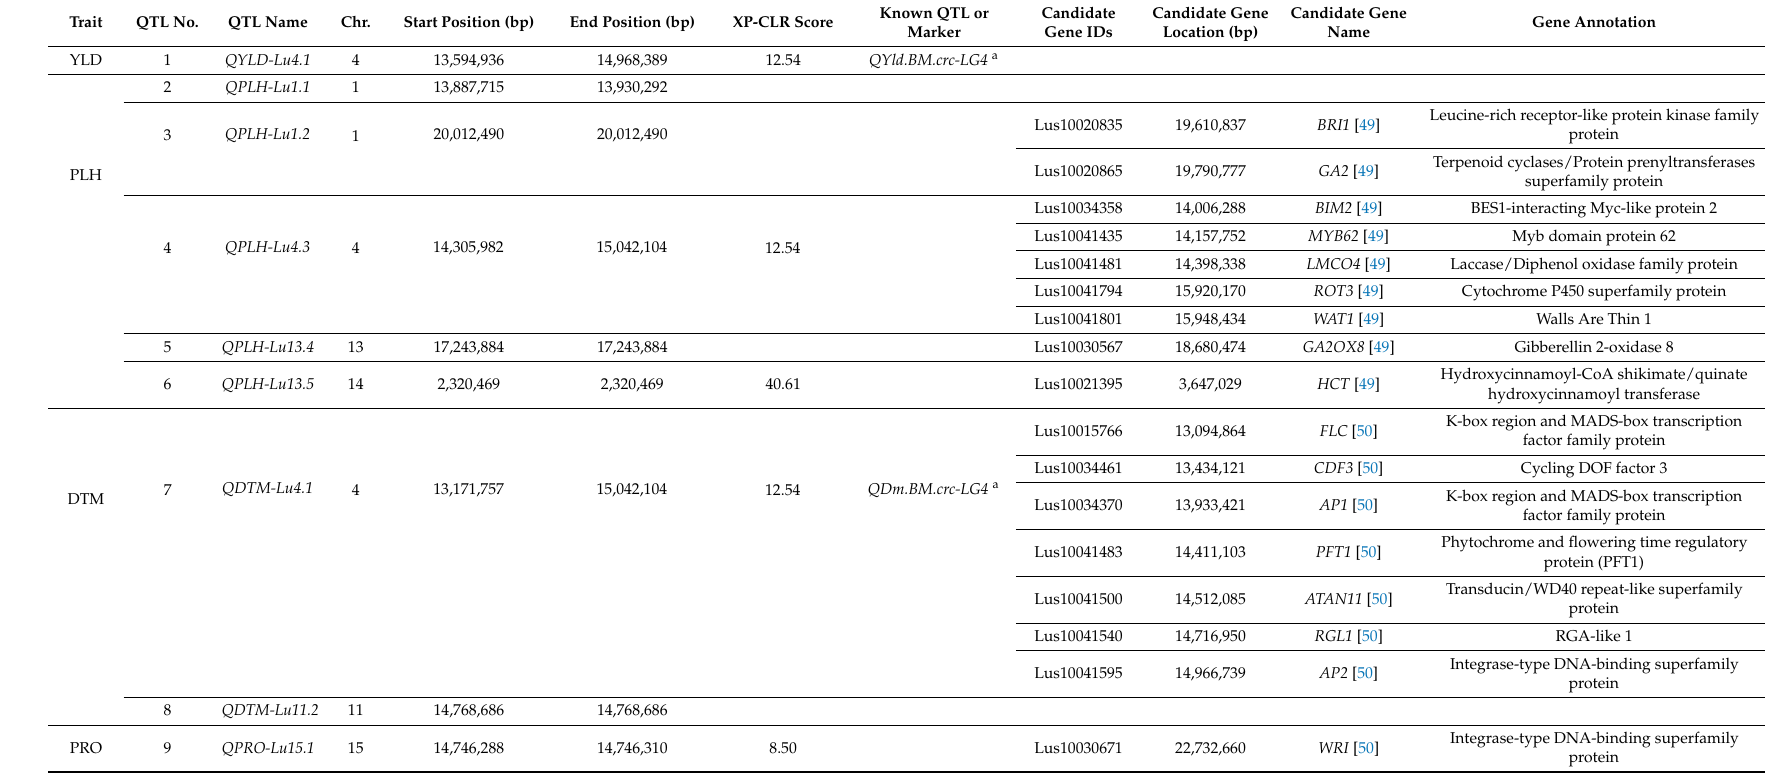
Table 3. QTL and associated gene